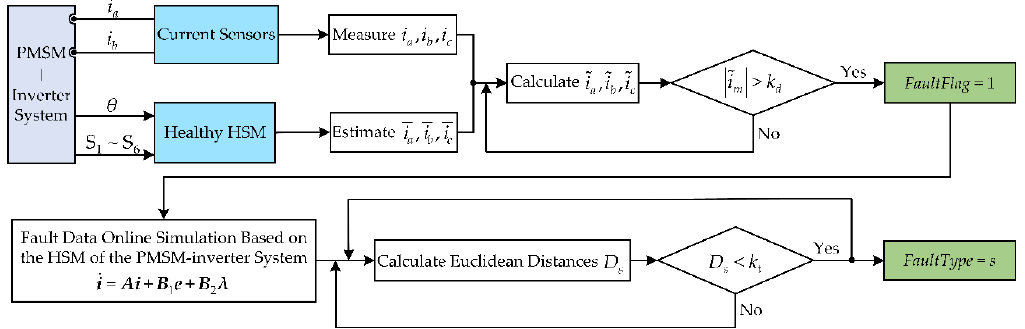
Figure 3. Flowchart of the proposed fault diagnosis algorithm.